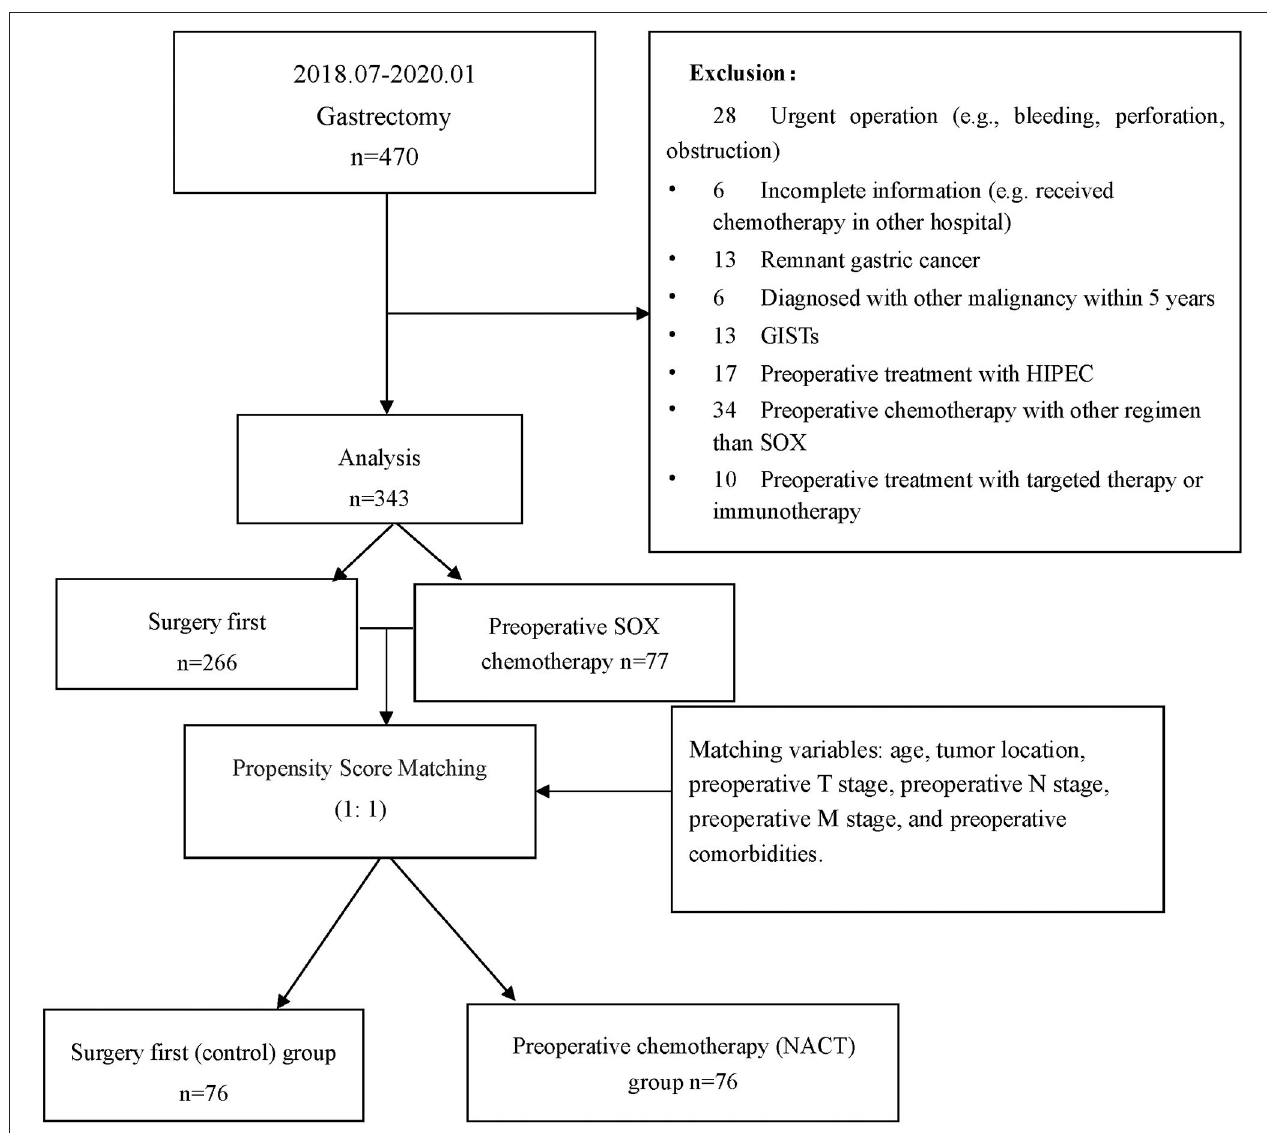
FIGURE 1 | Flowchart for patient inclusion and exclusion. *GIST, gastrointestinal stromal tumors; HIPEC, hyperthermic introperitoneal